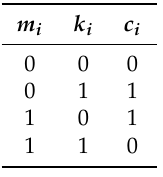
Table 1. xor truth